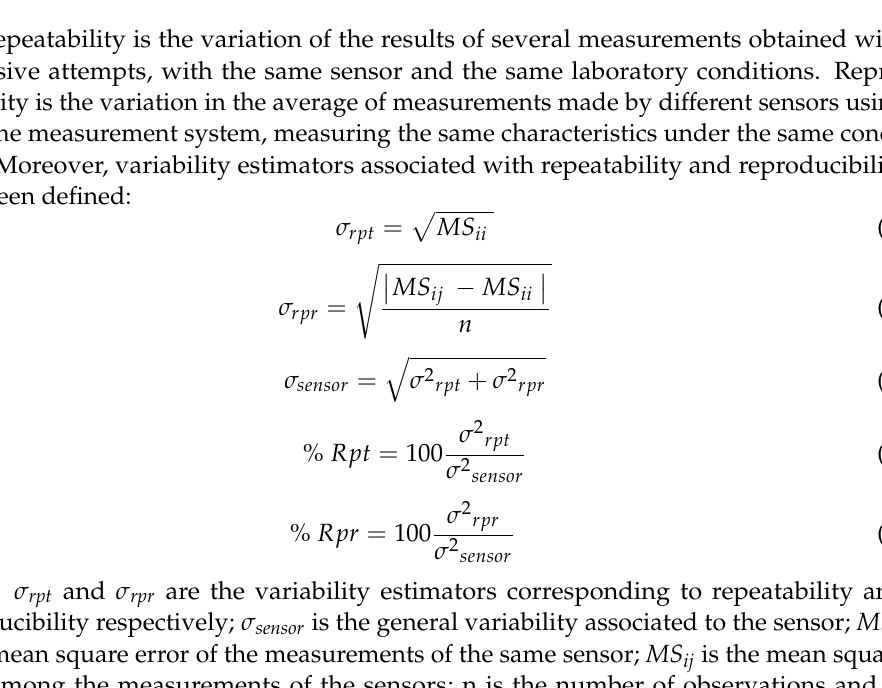
Figure 7. Graphical representation of the concept of repeatability and reproducibility.